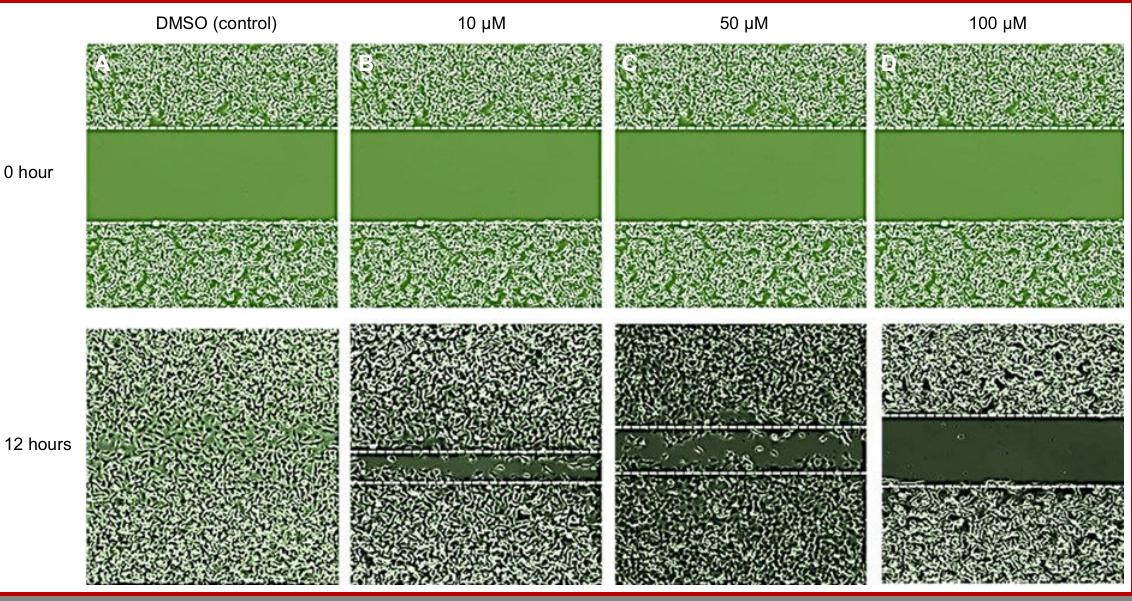
Figure 5: Syringin inhibits cell migration in HeLa human cervical cancer cells. The cells were treated with 0 (A), 10 (B), 50 (C) and 100 µM (D) of syringin. The number of cells that migrated into the scratched area was photographed (x 80) at 0 and 12 hours time intervals and calculated as a percentage of